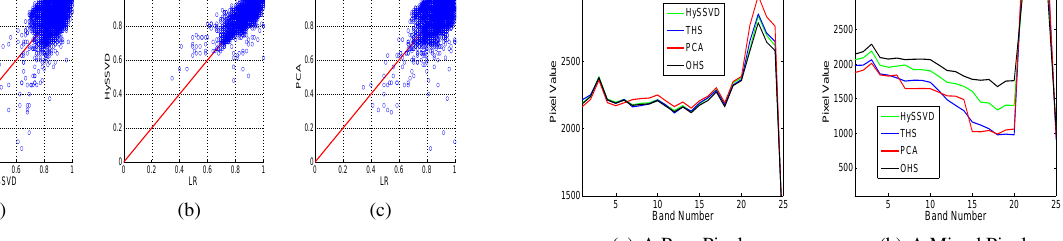
Figure 8: Scatter plot of Kendall Tau values for class Soyabean Method Soyabean Wheat